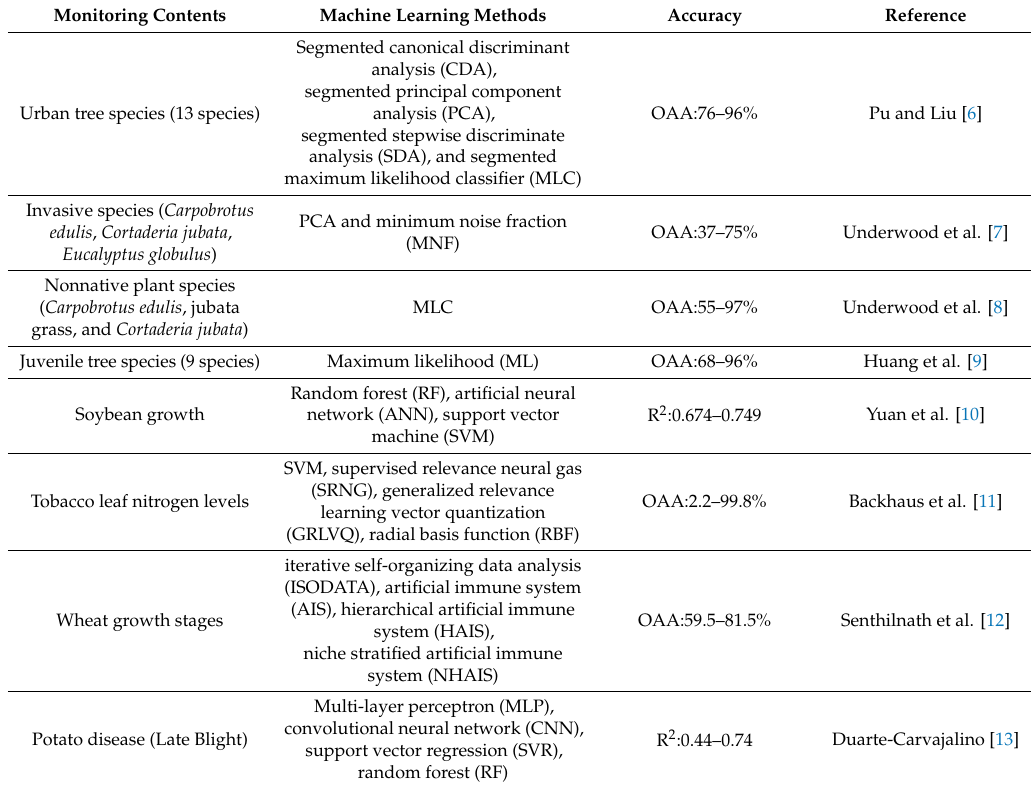
Table 1. Application of Machine